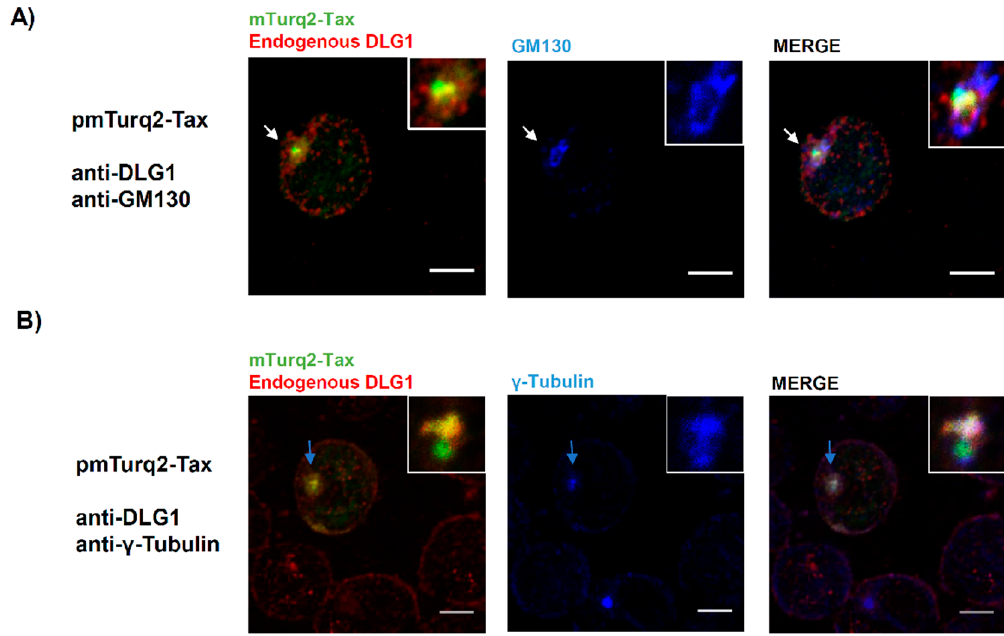
Figure 8. Association of DLG1-Tax complexes with the Golgi/MTOC region in T-cells. Evaluation of co-localization of Tax-DLG1 complexes (yellow) with GM130 (( A ), blue) and γ -tubulin (( B ), blue) by confocal microscopy. Endogenous DLG1, GM130, and γ -tubulin were detected by IF using their respective specific antibodies. The white ( A ) and light blue ( B ) arrows indicate the region amplified in the inset, showing the protein co-localization. All scale bars represent 5 µm.